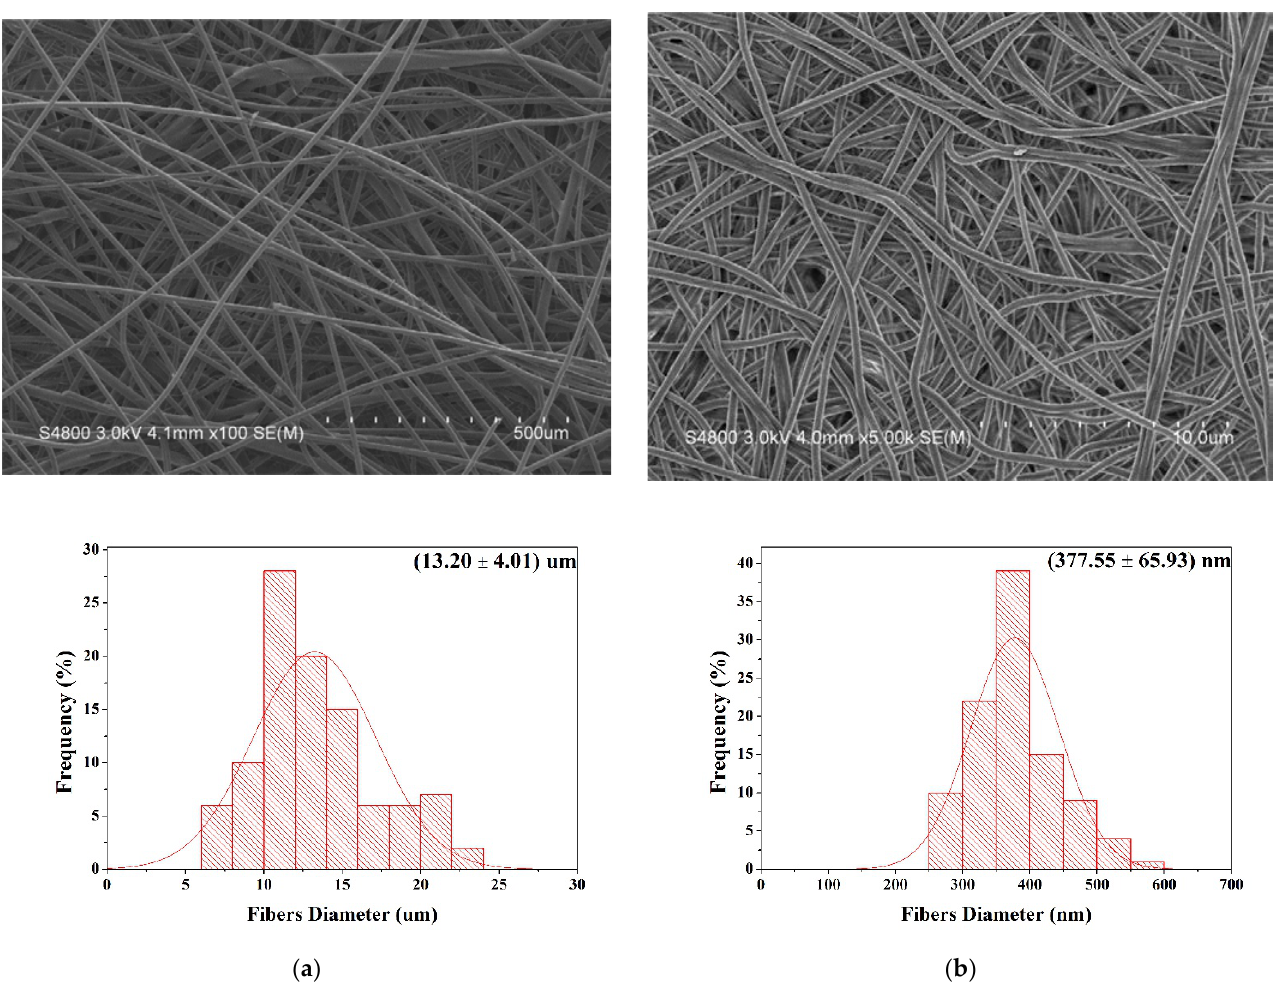
Figure 9. SEM images of ( a ) K40: ×100 ( b ) K40/PAN: ×5 K, showing the fiber morphology and diam- eter.